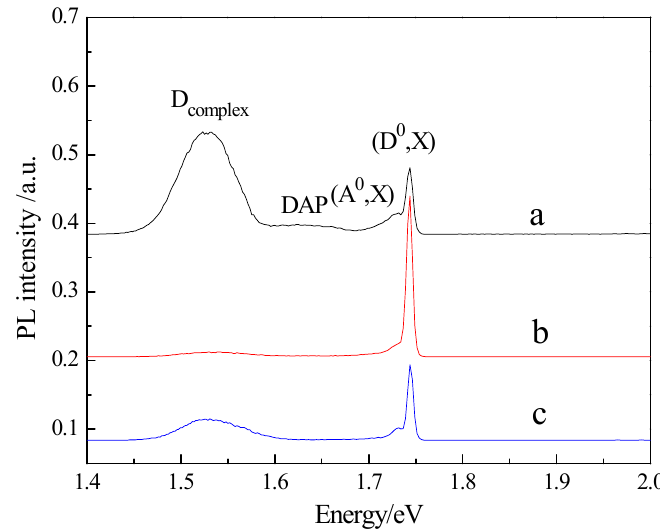
Figure 8. Photoluminescence (PL) spectra of CMT:In crystals before and after annealing: (a) as-grown (b) Cd atmosphere; (c) Te atmosphere.